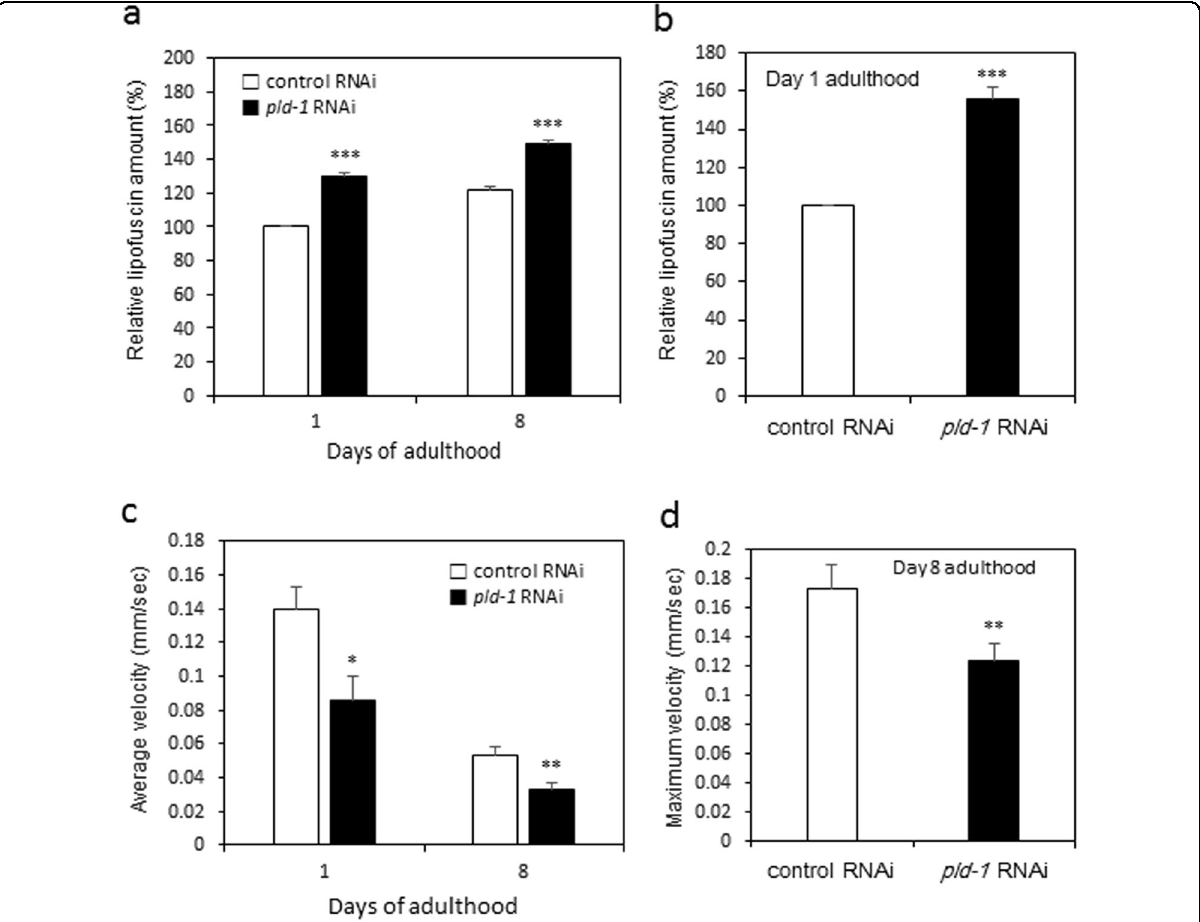
Fig. 3 Pld-1 RNAi increases lipofuscin accumulation and reduces the physical velocity of nematodes. a , b Effect of pld-1 RNAi on lipofuscin accumulation. a Age-synchronized L4 larvae were fed on control RNAi or pld-1 RNAi plates under standard conditions. b Effects of pld-1 RNAi on lipofuscin accumulation in nematodes fed pld-1 RNAi for 1 day at the L4 larval stage, to eliminate the effect of pld-1 knockdown on development. The auto fl uorescence images were obtained with a fl uorescence microscope. The fl uorescence intensity was quanti fi ed using ImageJ software by determining the average pixel intensity ( n >134 per day 1 condition; n >103 per day 8 condition). The average velocity ( c ) and maximum velocity ( d ) of individual nematodes were measured at day 1 or 8 of adulthood ( n = 20 per condition). Data are shown as the means±SEM. * P <0.05; ** P <0.01; *** P